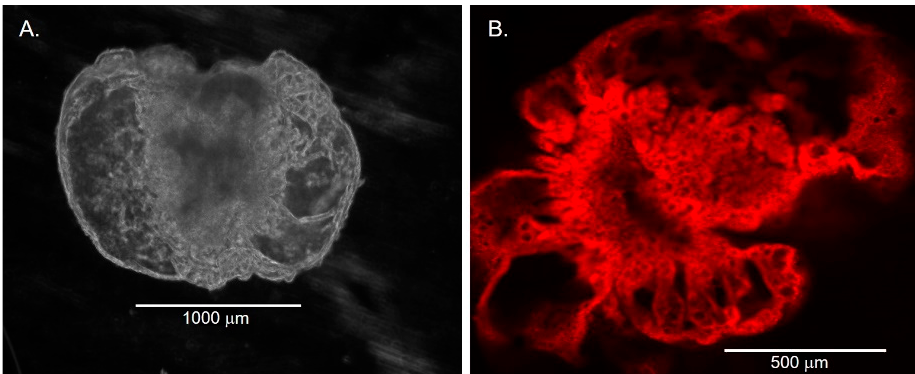
magnification in panel ( D ). Note the columnar epithelia along both lateral aspects of the lumen.